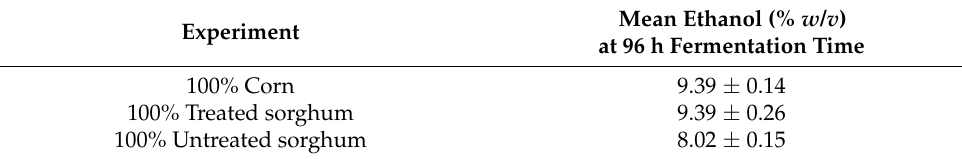
Table 1. Corn and sorghum fermentations, no cellulase added.